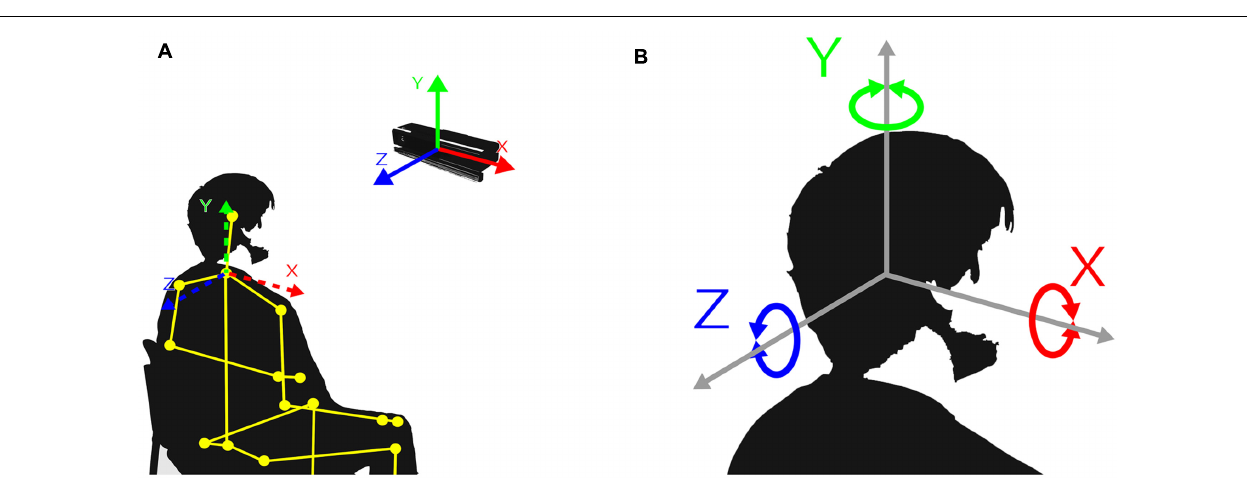
FIGURE 2 | Kinect coordinates: (A) body joint positions in relation to the coordinate system of the Kinect; (B) head rotation around the axes of the coordinate system of the